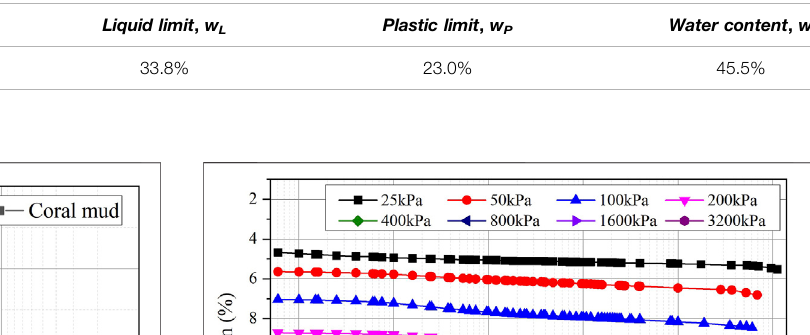
TABLE 1 | Basic properties of the coral mud.